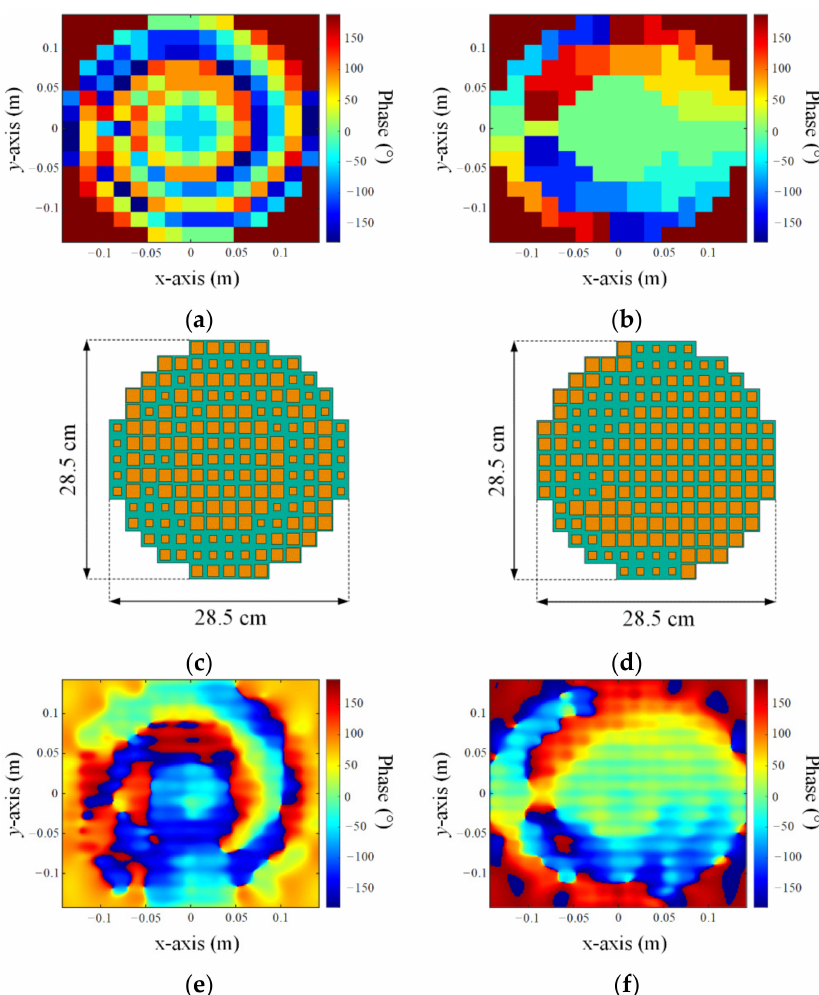
Figure 5. Transmitting phase distributions and geometry of the proposed MSLs: ( a ) theoretical trans- mitting phase distributions of T (cid:48) ; ( b ) theoretical transmitting phase distributions of T 2 ; ( c ) simulation 1 model of T (cid:48) ; ( d ) simulation model of T 2 ; ( e ) simulated transmitting phase distributions of T (cid:48) 1 ( f ) simulated transmitting phase distribution of T 2